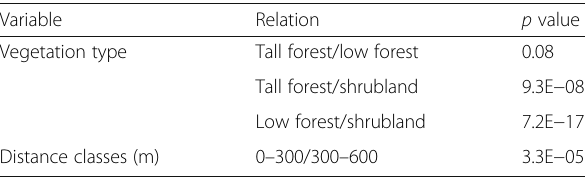
Table 2 Frequency comparison of vegetation types and distance classes